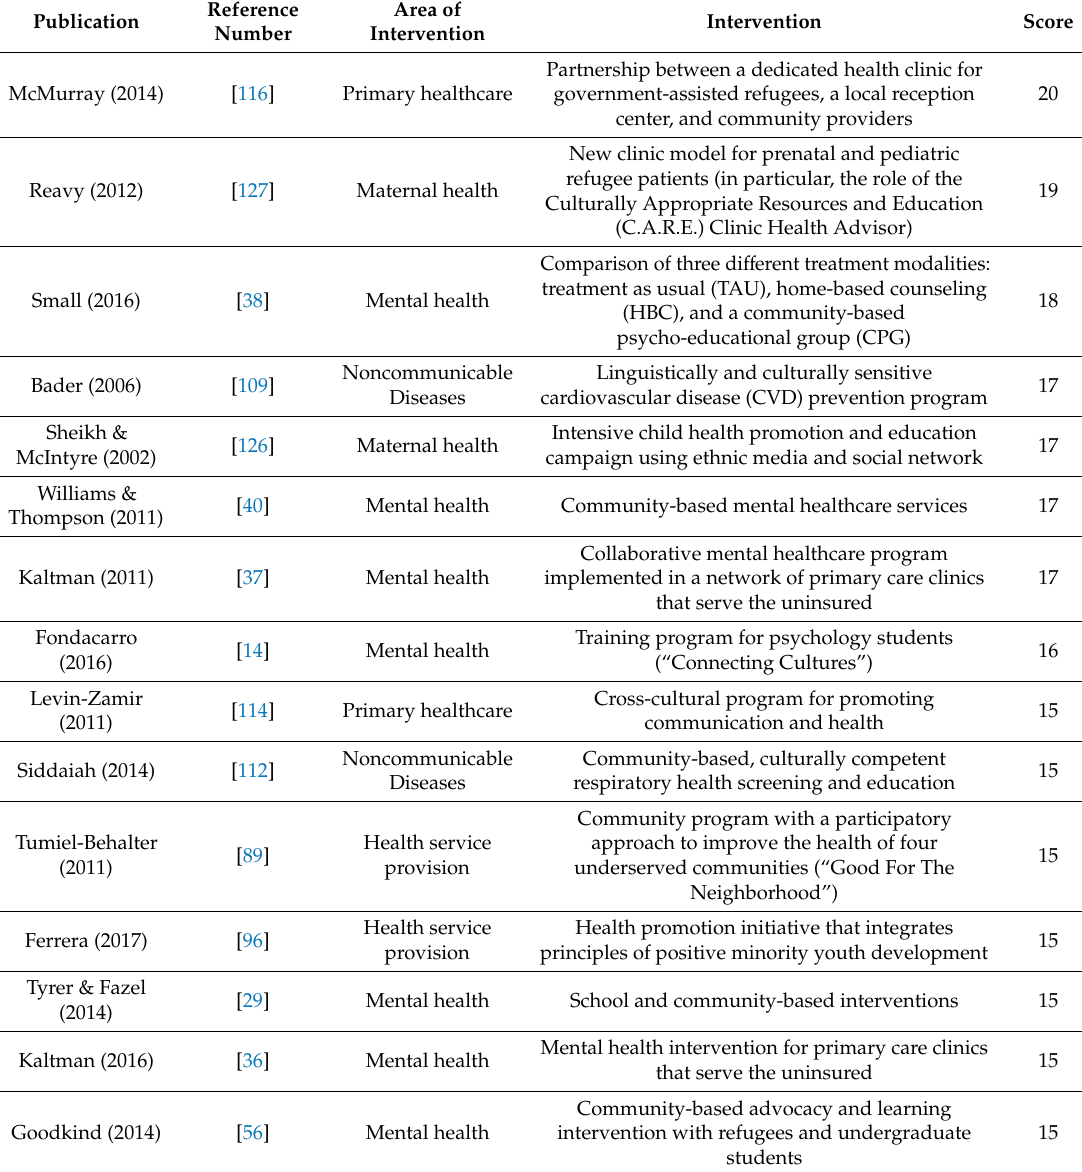
Table 2. The 15 highly assessed best